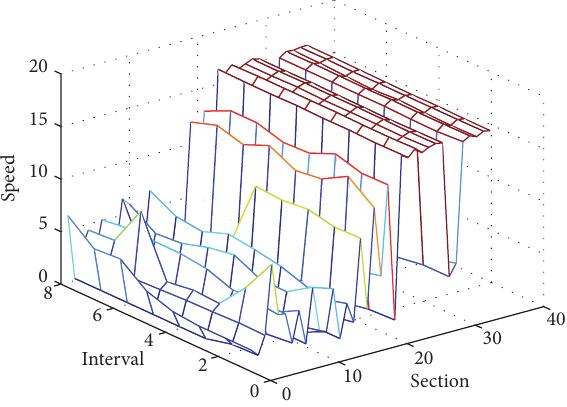
Figure 11: Averaged speed after